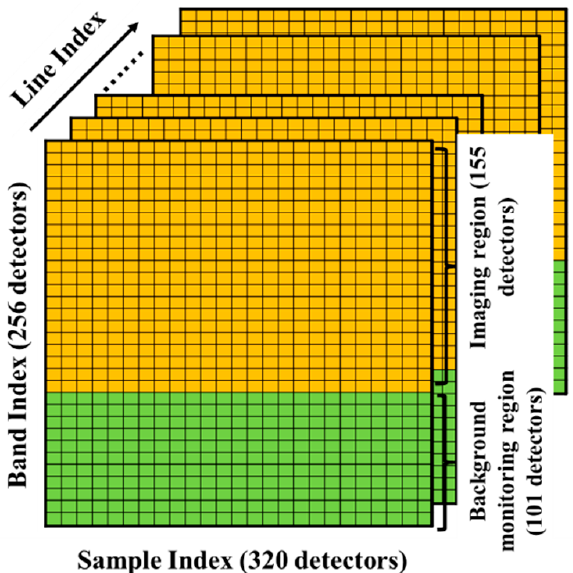
Figure 1. Schematic diagram of ATHIS data cube.